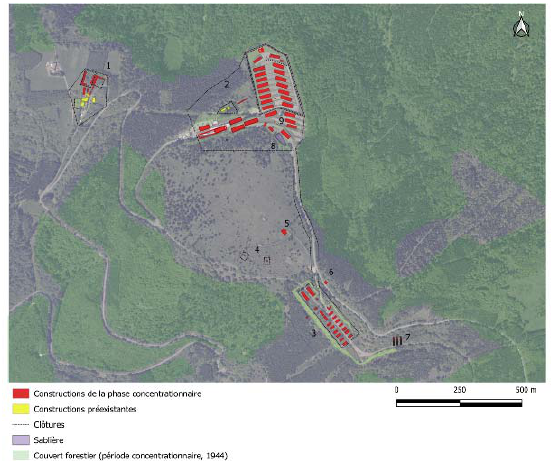
Figure 1 : Camp map, state 1944 (J. Brangé, aerial photo IGN